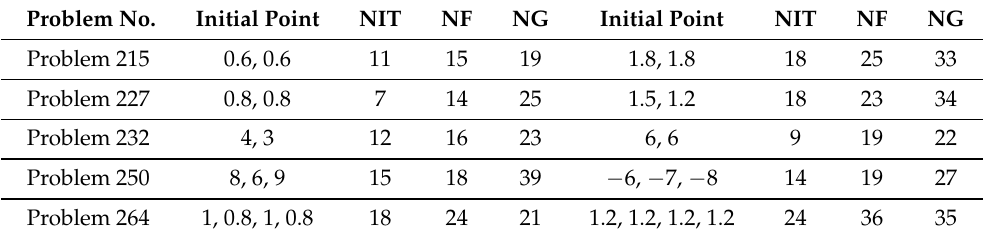
Table 1. Computational results of Algorithm